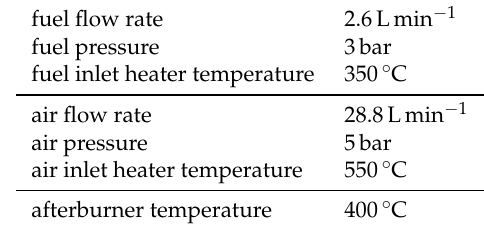
Table 3. Modular stack test bench operating conditions.